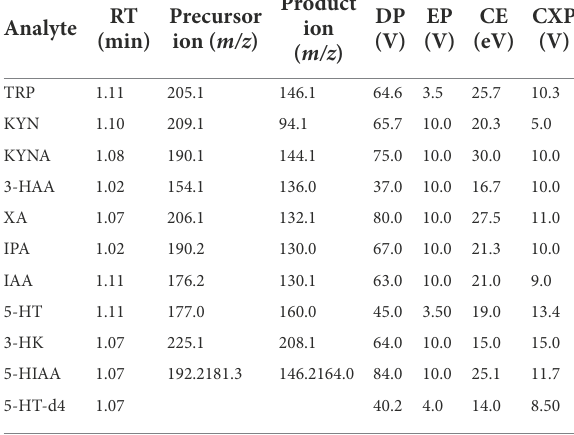
TABLE 1 Optimal values of mass spectrometry parameters of TRP, its nine metabolites, and the internal standards.